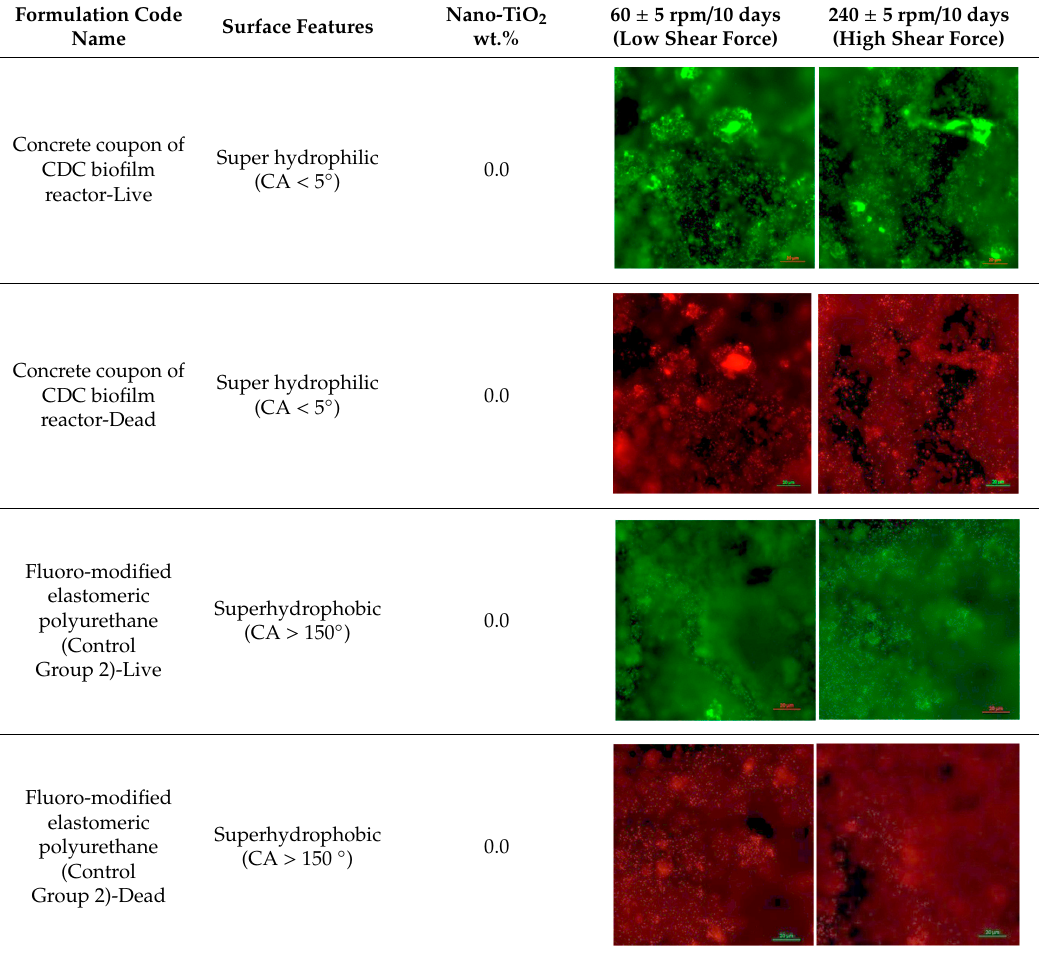
Table 5. Live/dead microscopy of control group excluding the effect from nano-TiO 2.